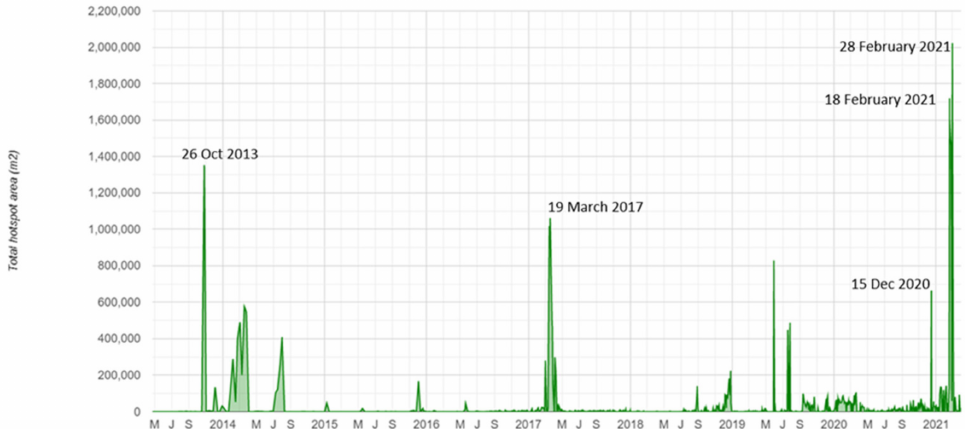
Figure 8. Plot of hotspot area generated through the NHI tool, integrating L8-OLI (from April 2013 onwards) and S2-MSI observations (from June 2015 onwards).